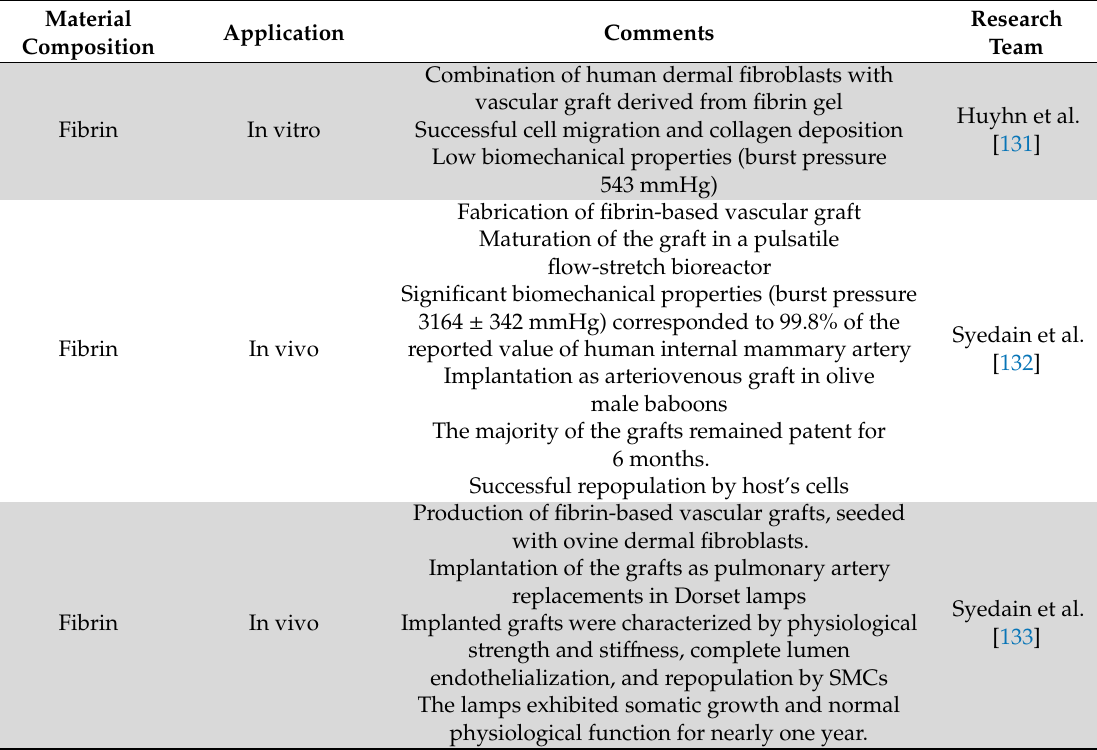
Table 3. Representative applications of TEVGs derived from